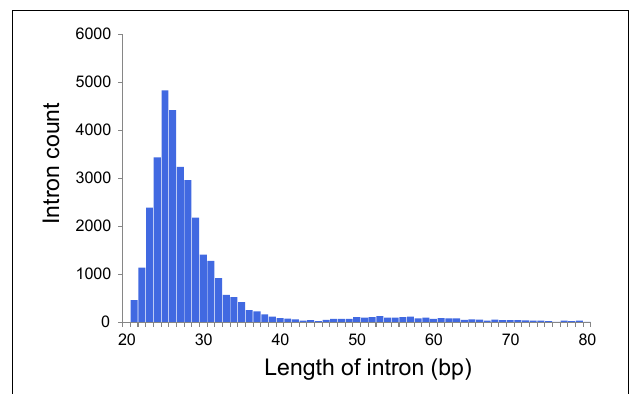
FIGURE 1 | Distribution of intron lengths in predicted genes of Dicyema sp.